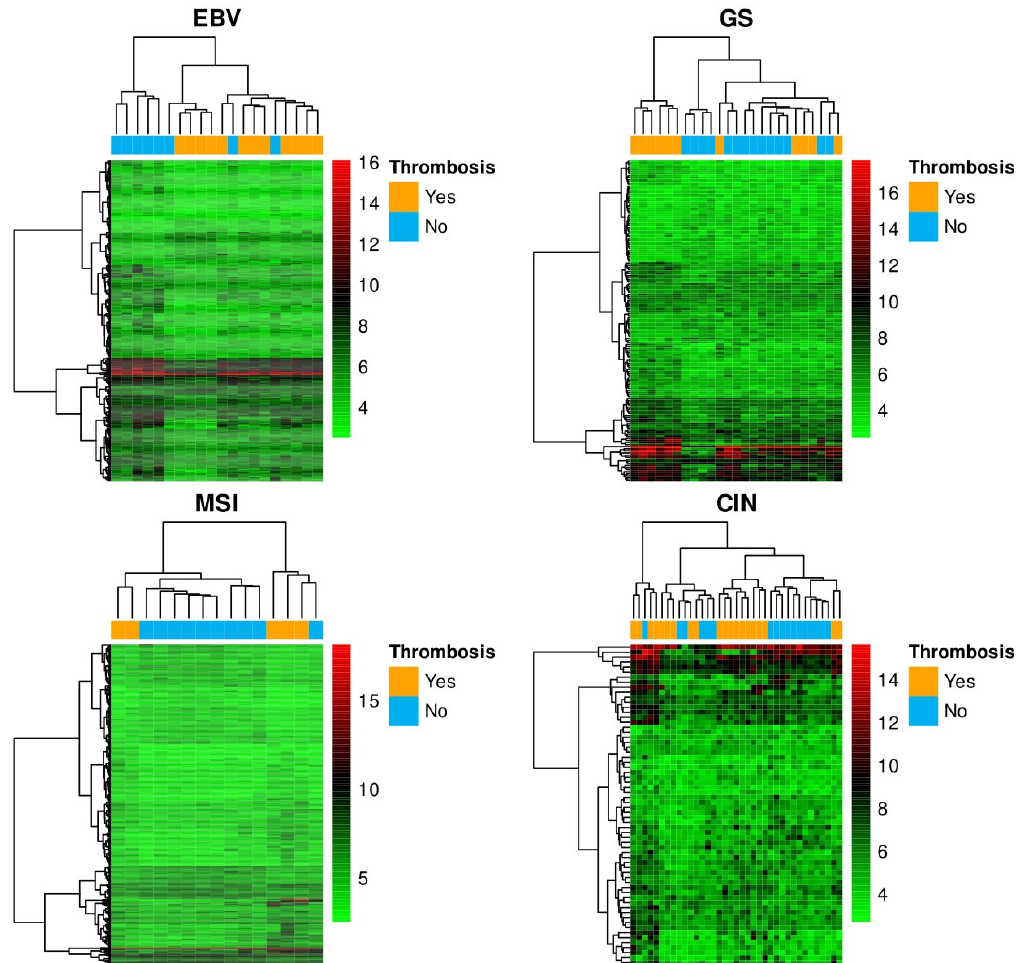
Figure 3. Descriptive heat maps of the differential gene expression between patients with thrombosis and controls within each TCGA category. The dendrogram on the left represents differentially expressed genes between individuals with thrombosis and controls, whereas the one on top represents the samples. In the rows corresponding to the expression of each gene, the shade of red indicates high relative expression with respect to the shade of green. EBV: Epstein–Barr associated tumors; GS: genetically stable tumors; MSI: tumors with microsatellite instability; CIN: chromosomally unstable tumors. Table 5. Within each TCGA category, differentially expressed genes between patients with venous thromboembolism and controls that were associated to hemostatic pathways according to RE- ACTOME software. Fold change quantifies differences in gene expression when comparing thrombotic patients respecting to controls. p -value indicates significance grade of gene expression differences between thrombotic cases and controls. Column on the right shows specific pathways related to hemostasis to which genes are associated, according to REACTOME software.